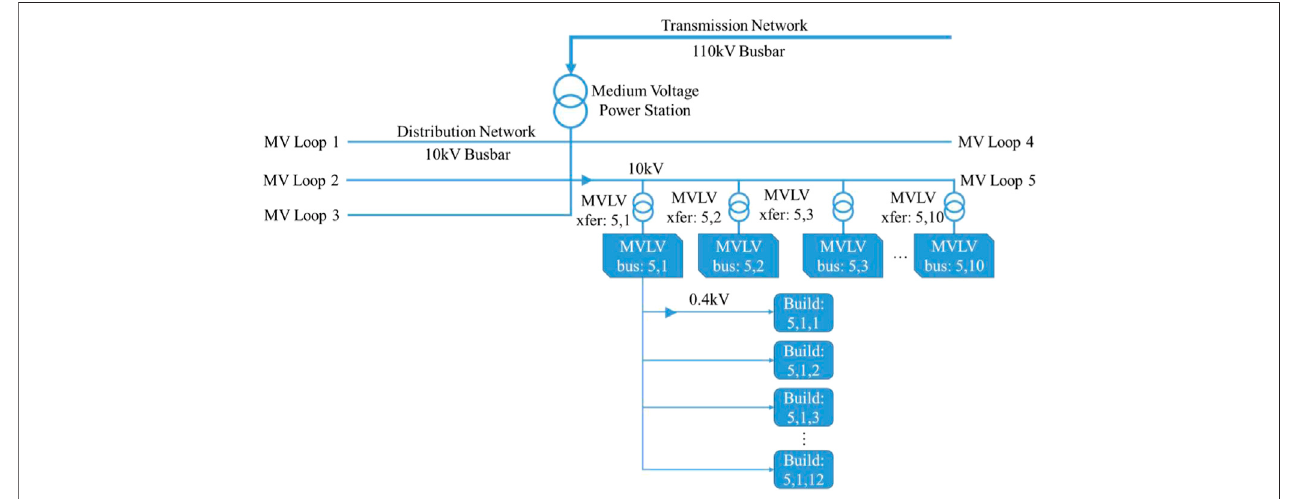
FIGURE 3 | Electrical distribution networks hierarchical